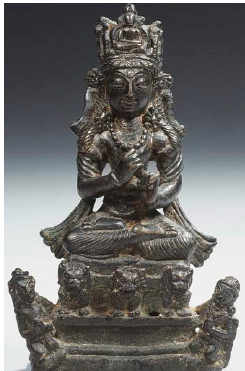
Figure 29. Vairocana in sambhogak ā ya form performing the bodhy ā gr ī mudr ā , eighth to ninth c. Swat. Bronze with silver inlay. 12.7 cm H. Private Collection. https://himalayanbuddhistart.files.wordpress.com/2012/10/8-9th-c-swat-valley-vairocana-bronzesil-eyes-127-cm-christies.jpg.